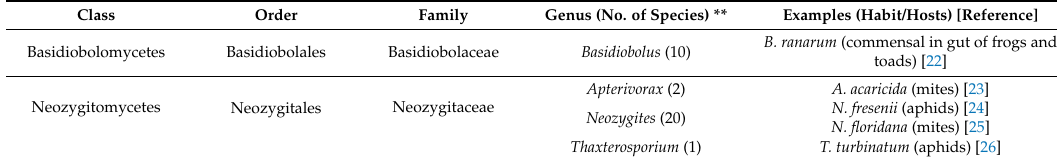
Table 1. Classification of subphylum Entomophthoromycotina (phylum Zoopagomycota)